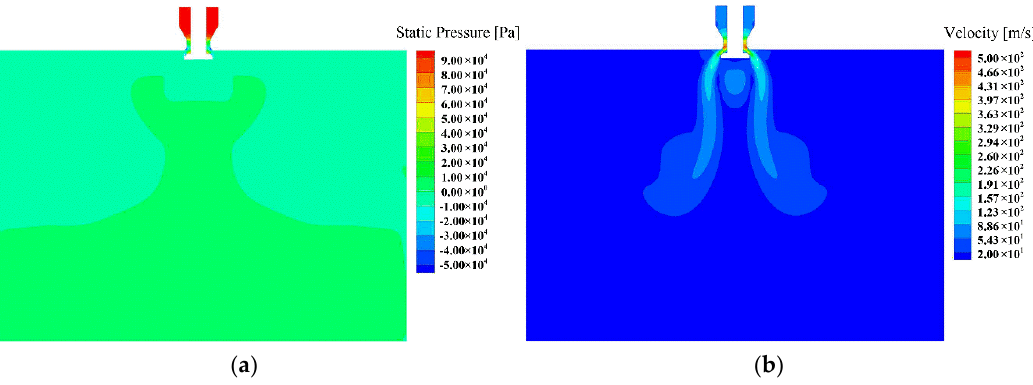
Figure 10. The outflow pressure and velocity contour of the type A push-open injector. (a) Static pressure contour; (b) Velocity contour (inlet pressure 1bar).